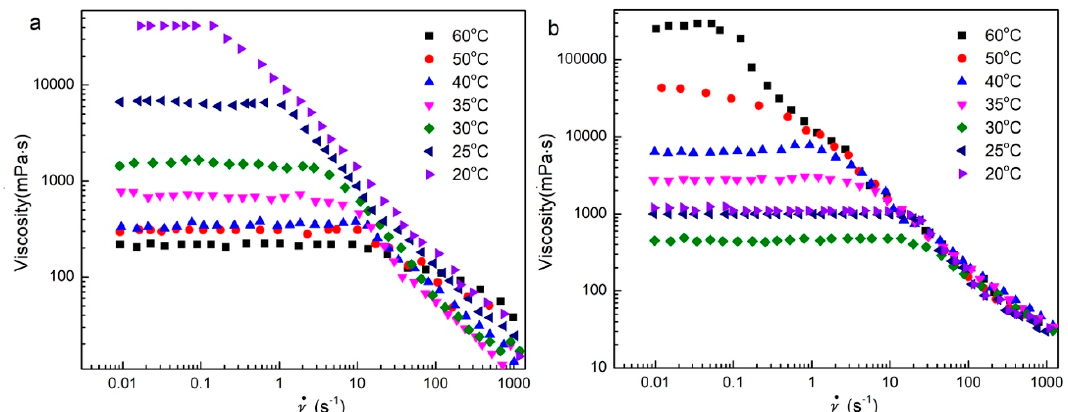
Figure 7. Rheological behavior of ( a ) S2 and ( b ) S3 with different shear rate and temperature. C p = 2.0 wt %.